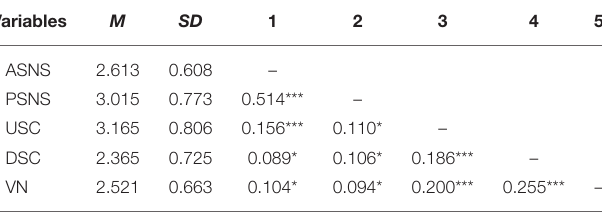
TABLE 1 | Descriptive statistics and inter-correlations between main variables.